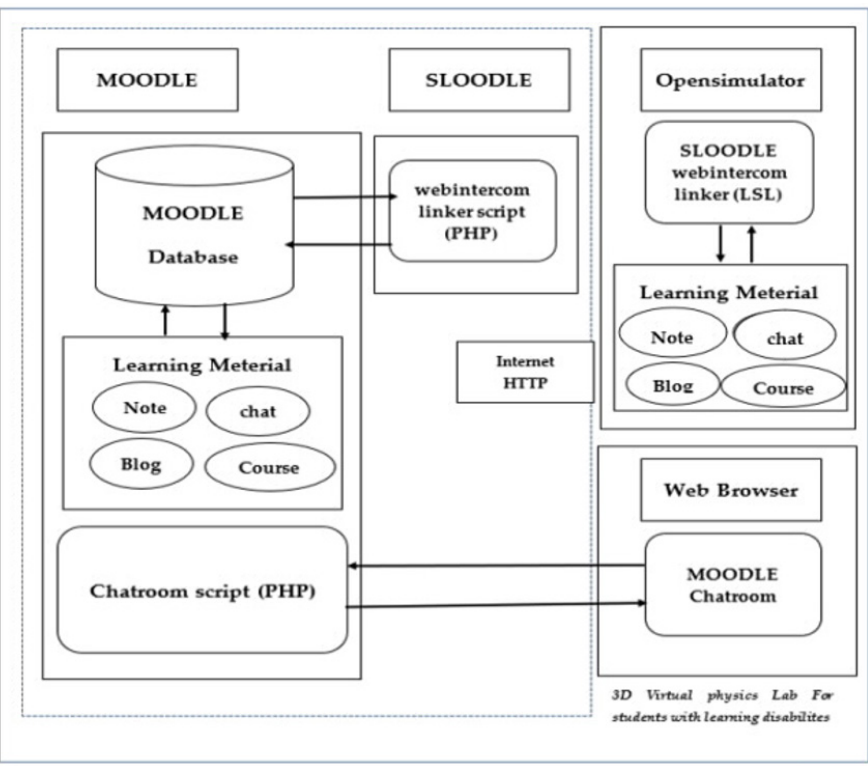
Figure 1. Proposed virtual physics laboratory architecture.